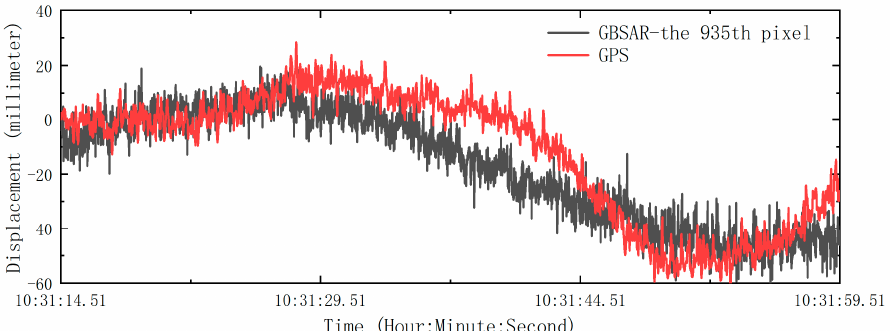
Figure 13. Comparison of the result of GBSAR at the 935th pixel and the time series acquired by the GPS receiver.